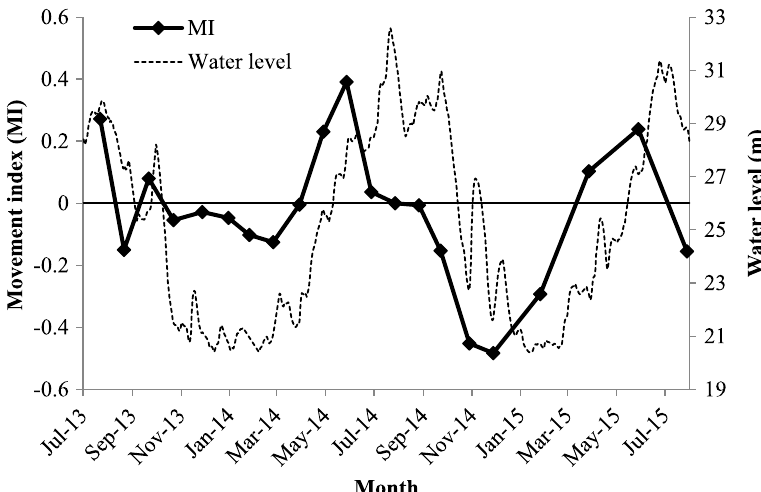
Fig. 7. Movement index ( MI ) of Coilia brachygnathus in the channel connecting Dongting Lake and the Yangtze River from July 2013 to July 2015, and water level is given as example to illustrate the relationship with environmental